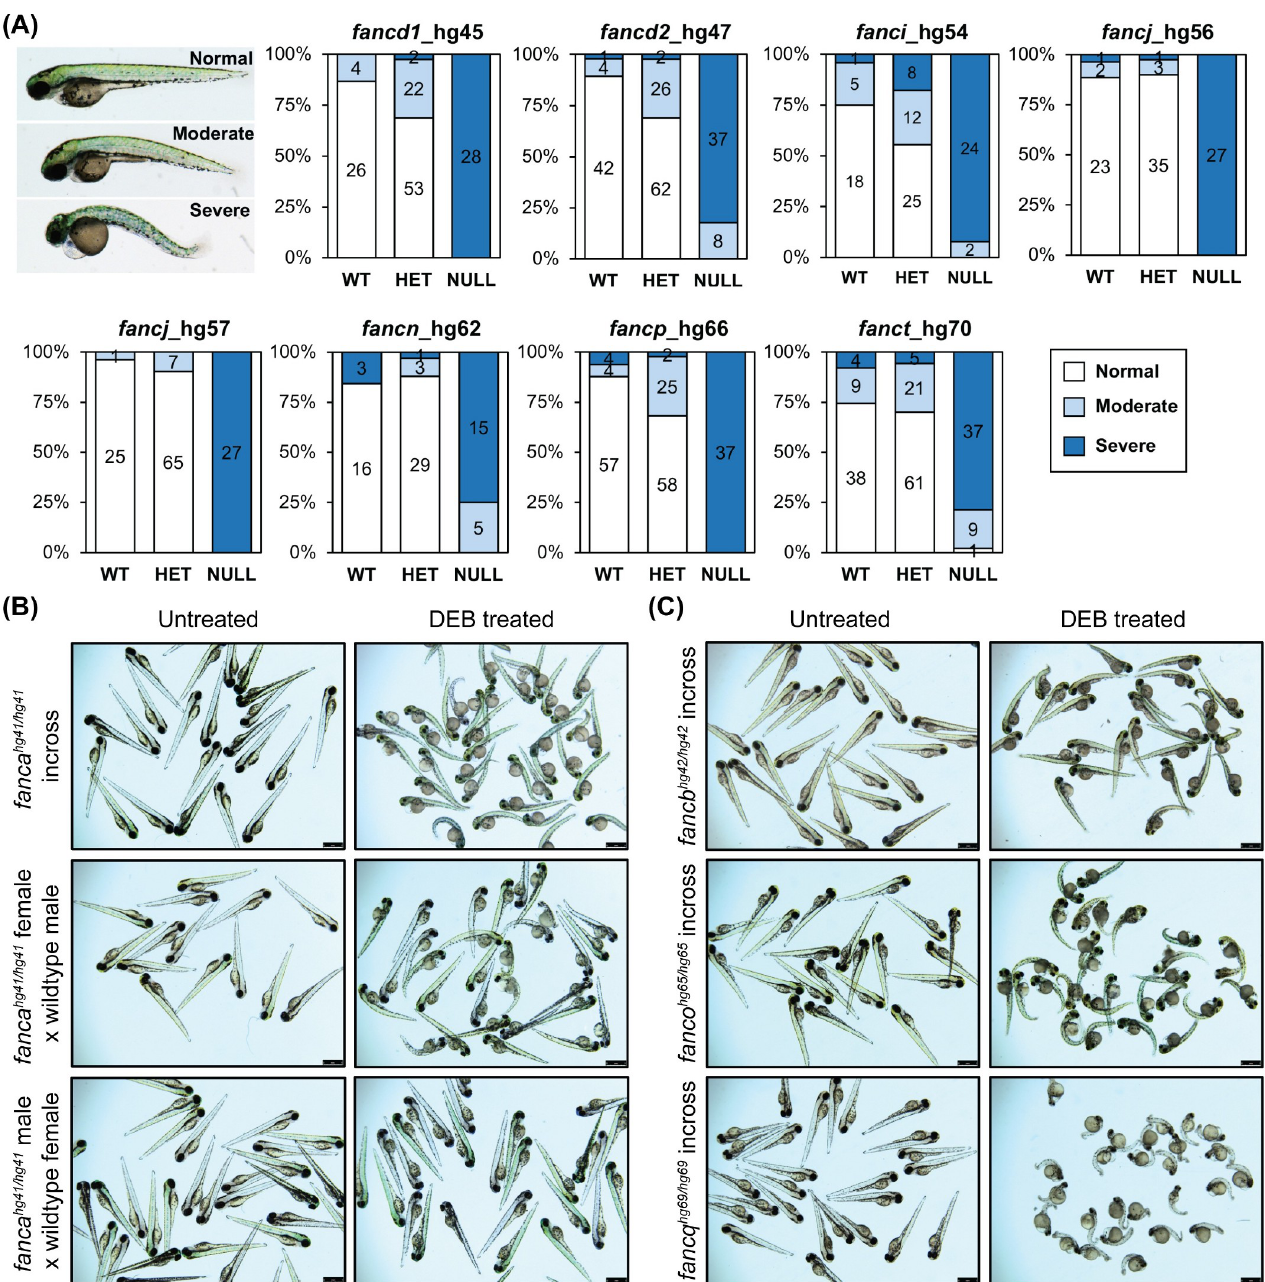
Fig 2. Homozygous knockout mutants are sensitive to DEB treatment. (A) Embryos obtained from inbreeding heterozygous knockouts of fancd1 (hg45; 0.9 μ g/mL DEB), fancd2 (hg47; 0.9 μ g/mL DEB), fanci (hg54; 0.65 μ g/mL DEB), fancj (hg56 and hg57; 0.6 μ g/mL DEB), fancn (hg62; 0.8 μ g/mL DEB), fancp (hg66; 0.9 μ g/mL DEB) and fanct (hg70; 0.8 μ g/mL DEB) were treated at indicated DEB concentrations between 4–72 hpf. Treated embryos were classified based on severity of morphological changes observed into three phenotypic groups: normal (WT appearance), moderate (slight body curvature and minor edema) and severe (emaciated appearance, severe body curvature and large edema). An example image of DEB treated embryo (72 hpf) for each group is shown on the left. Distribution of each phenotypic group for a given genotype are displayed as stacked bar chart. The segments in bar show percent of embryos in each morphological group: normal (white), moderate (light blue), severe (dark blue). The number in each segment depicts the number of embryos for a given phenotypic group. (B) Maternal WT fanca transcript rescues embryos from DEB hypersensitivity. Embryos obtained from indicated fanca _hg41 breeding were treated with DEB (0.8 μ g/mL). Representative images show untreated and DEB treated embryos. (C) Embryos generated from inbreeding of homozygous knockouts of fancb (hg42; 0.8 μ g/mL DEB), fanco (hg65; 0.8 μ g/mL DEB) and fancq (hg69; 0.5 μ g/mL DEB) were treated at indicated DEB concentrations. Representative images show untreated and DEB treated